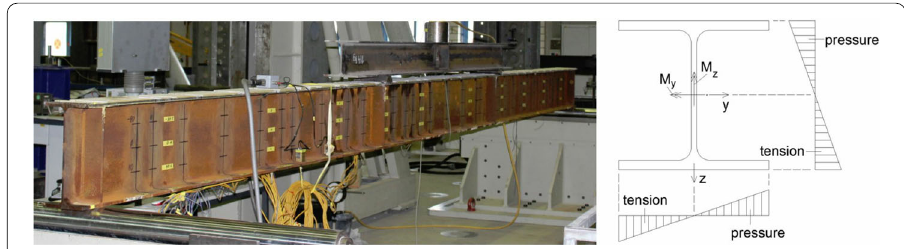
Figure 1 Left: Beam in lab test. Right: Anti-symmetric stress distribution in the cross